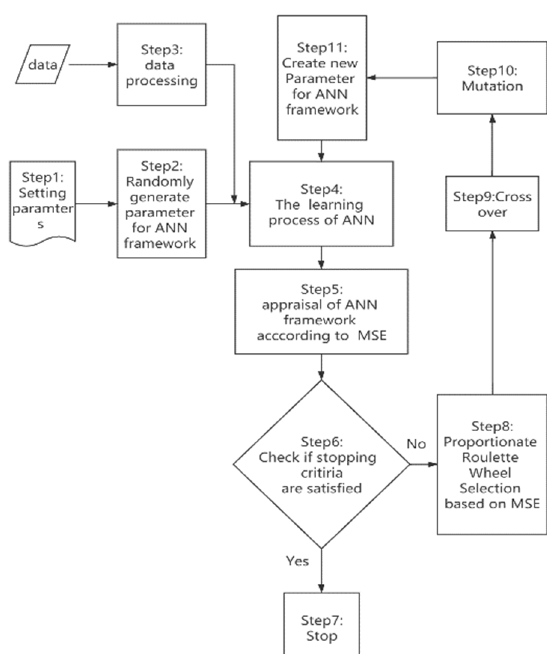
Fig. 1. Flow chart of the GANN.